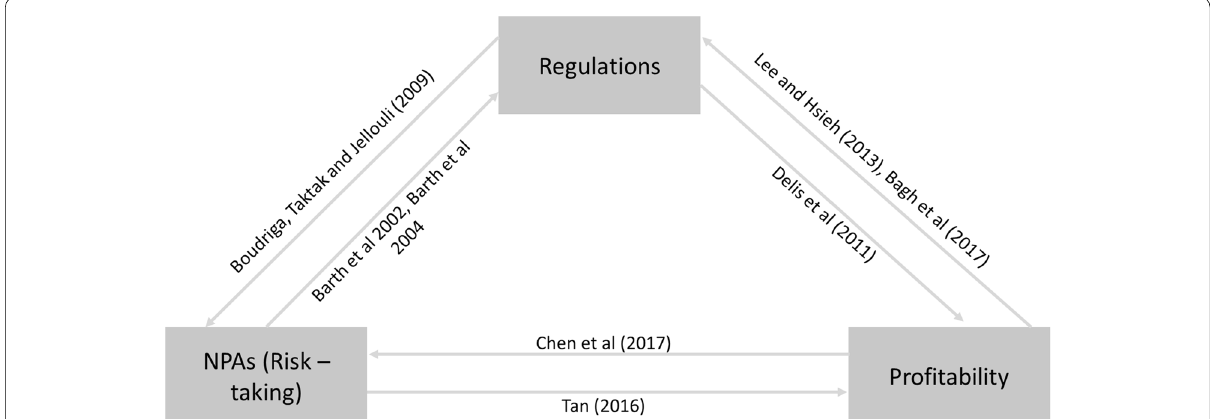
Fig. 1 Triad of Profitability, regulation, and NPA (risk-taking). Note The triad [131] of profitability, regulation, and NPA (risk-taking) is shown in Fig.